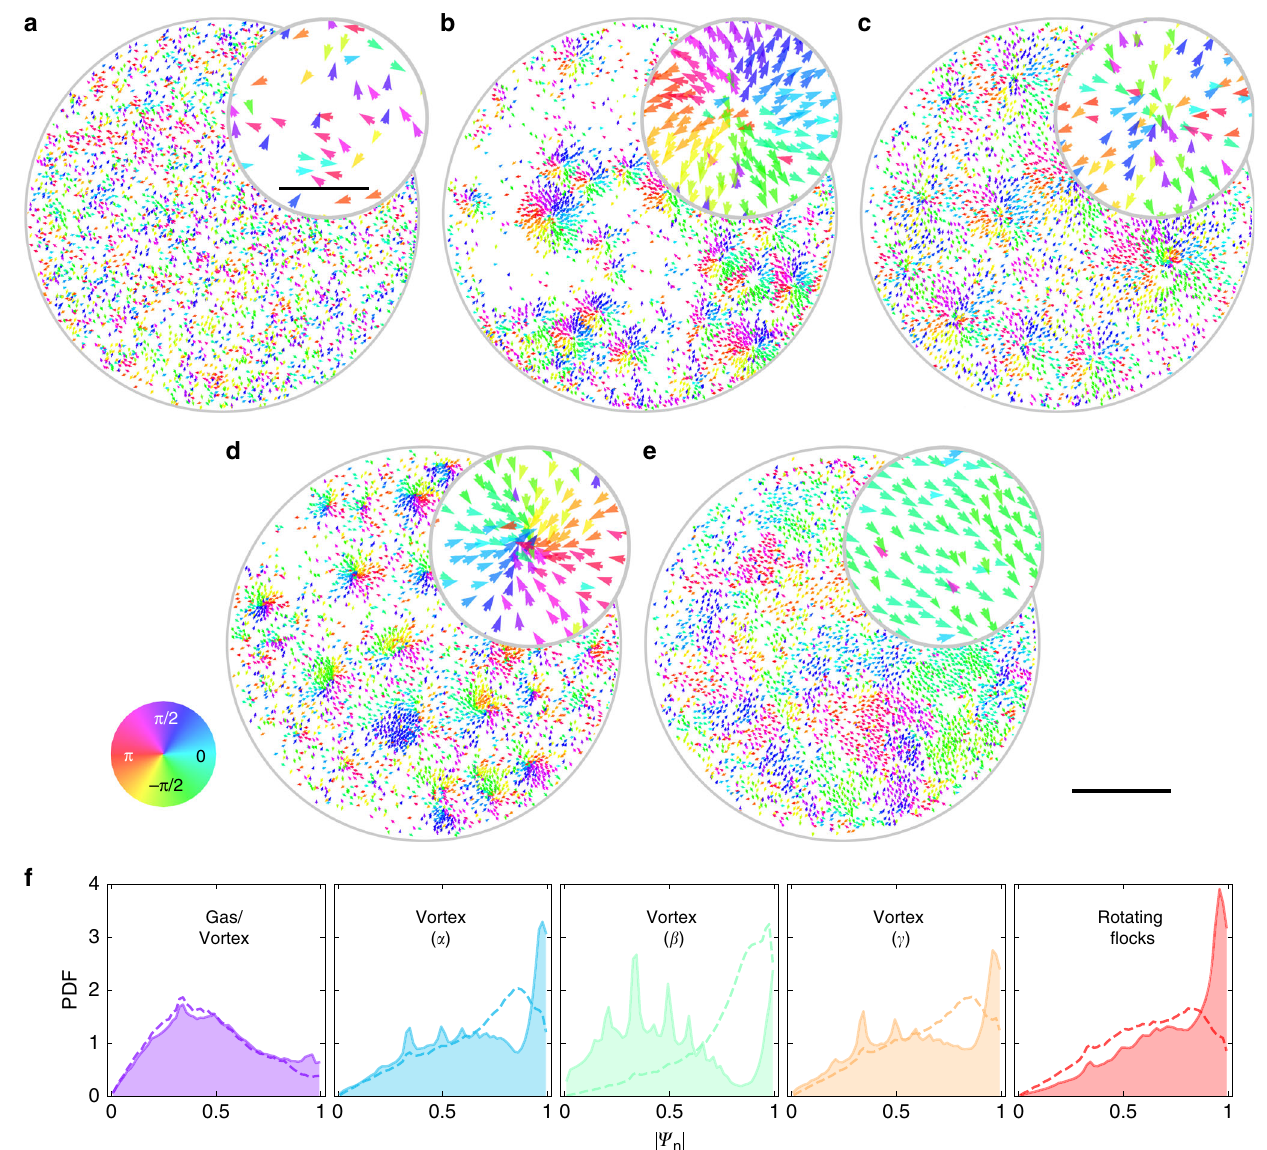
Fig. 4 Local order inside of collective chiral rollers states. a Uncorrelated gas of chiral rollers. E = 1.60 V μ m − 1 . b α - ( ‘ heads-out ’ ) vortices. E = 1.76V μ m − 1 . c β -vortices. E = 1.92 V μ m − 1 . d γ - ( ‘ heads-in ’ ) vortices. E = 2.08 V μ m − 1 . e Rotating fl ocks. E = 2.40 V μ m − 1 . In a – e particle orientations are shown as arrow-heads and also color coded to better visualize rotating fl ocks and vortex patterns in the system. Area fractions correspond to ϕ = 0.108. The inserts demonstrate the local order and are representative zoomed-in areas from the corresponding panels. Scale bars are 0.5 mm for the main panels and 0.1 mm for the inserts. f Probability distribution functions of the local orientational polar order parameters, ∣ Ψ 1 ∣ (solid lines), and nematic order parameters, ∣ Ψ 2 ∣ (dashed lines), calculated for emergent collective patterns shown in ( a ) – ( e ). α -, γ -Vortices and Rotating fl ocks exhibit a polar local ordering, while β - vortices show tendency toward a local nematic of the chiral rollers ’ trajectories increases (with the strength of the applied electric fi eld) the persistence length (and as a result the interaction length scale) decreases, and the circular motion of rollers becomes more localized. The rollers cannot sustain large-